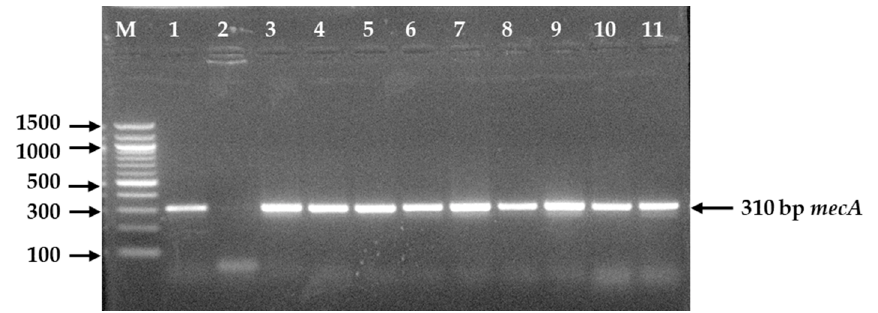
Figure 5. PCR amplified product of 310 bp from mecA gene of MRSA and MSSA following 1.5% agarose gel electrophoresis and ethidium bromide staining. Legends: M = DNA marker (100 bp), Lane 1 = Positive control of mecA gene, Lane 2 = Negative control, Lane 3–11 = Positive for mecA gene.